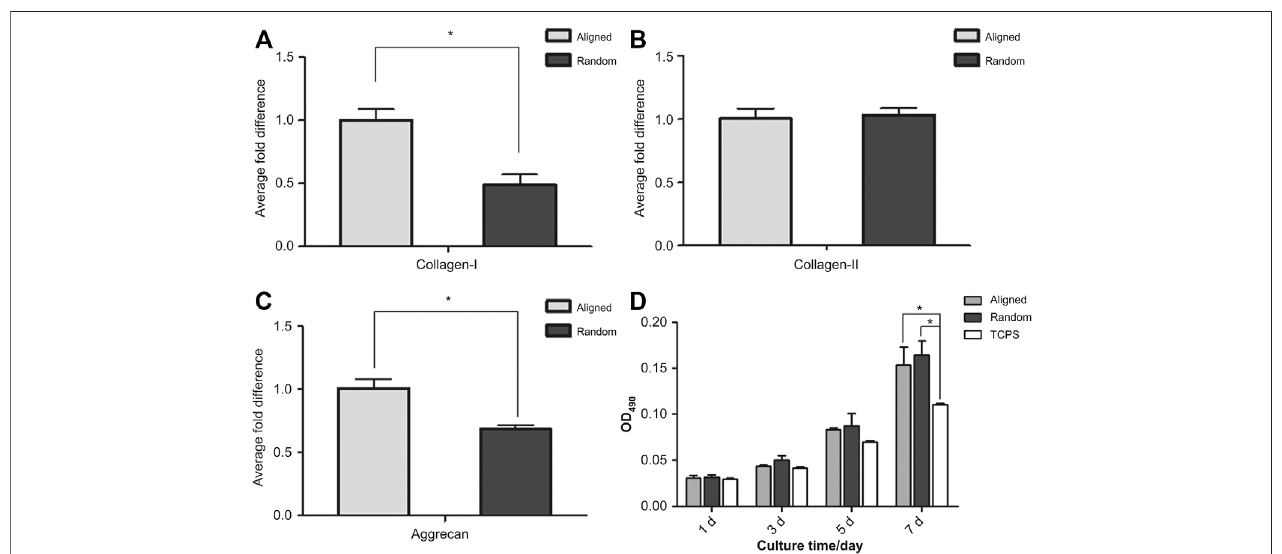
FIGURE 4 | (A) Real-time quantitative PCR was performed to compare the expression of collagen-I, collagen-II and aggrecan genes in AFSCs cultured on aligned and random scaffolds. After 7 days of culture, the expression level of collagen-I in AFSCs cultured on aligned scaffolds was almost twice that of cells grown on random scaffolds. (B) The expression of collagen-II was similar in both AFSCs cultured on aligned and random scaffolds. (C) The expression pattern of aggrecan was similar to that of collagen-I; cells cultured on aligned scaffolds had approximately 0.4 times higher aggrecan gene expression than those grown on random scaffolds. (D) TherewasnoapparentdifferenceincellproliferationbetweenAFSCsculturedonalignedscaffoldsandthoseonrandomscaffolds.( (A – D)